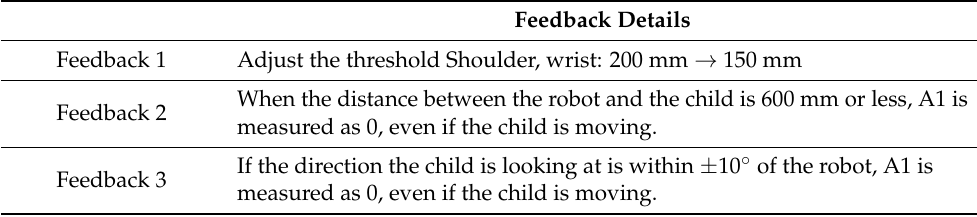
Table 5. Modification of index extraction algorithm according to feedback reflection.